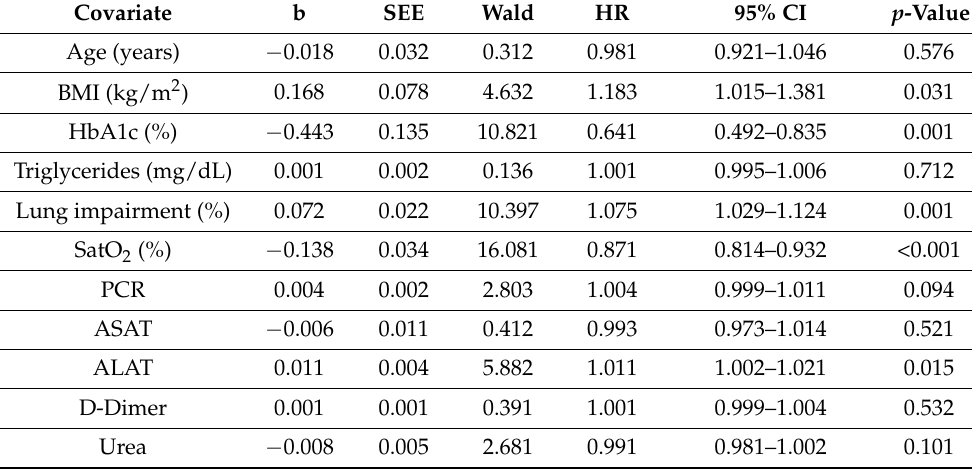
Table 3. Factors influencing the length of